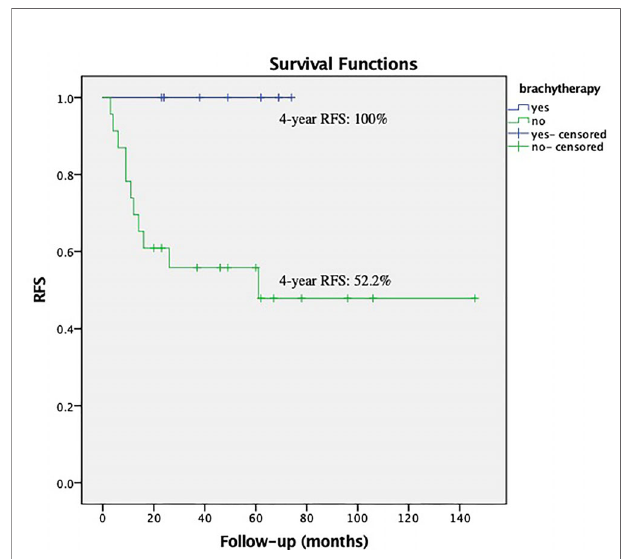
FIGURE 3 | Recurrence Free Survival (RFS) with or without vaginal cuff brachytherapy in patients with deep stromal invasion that received low external beam radiation therapy. The 4-year RFS was 100.0% vs. 52.2%, respectively, P = 0.018.